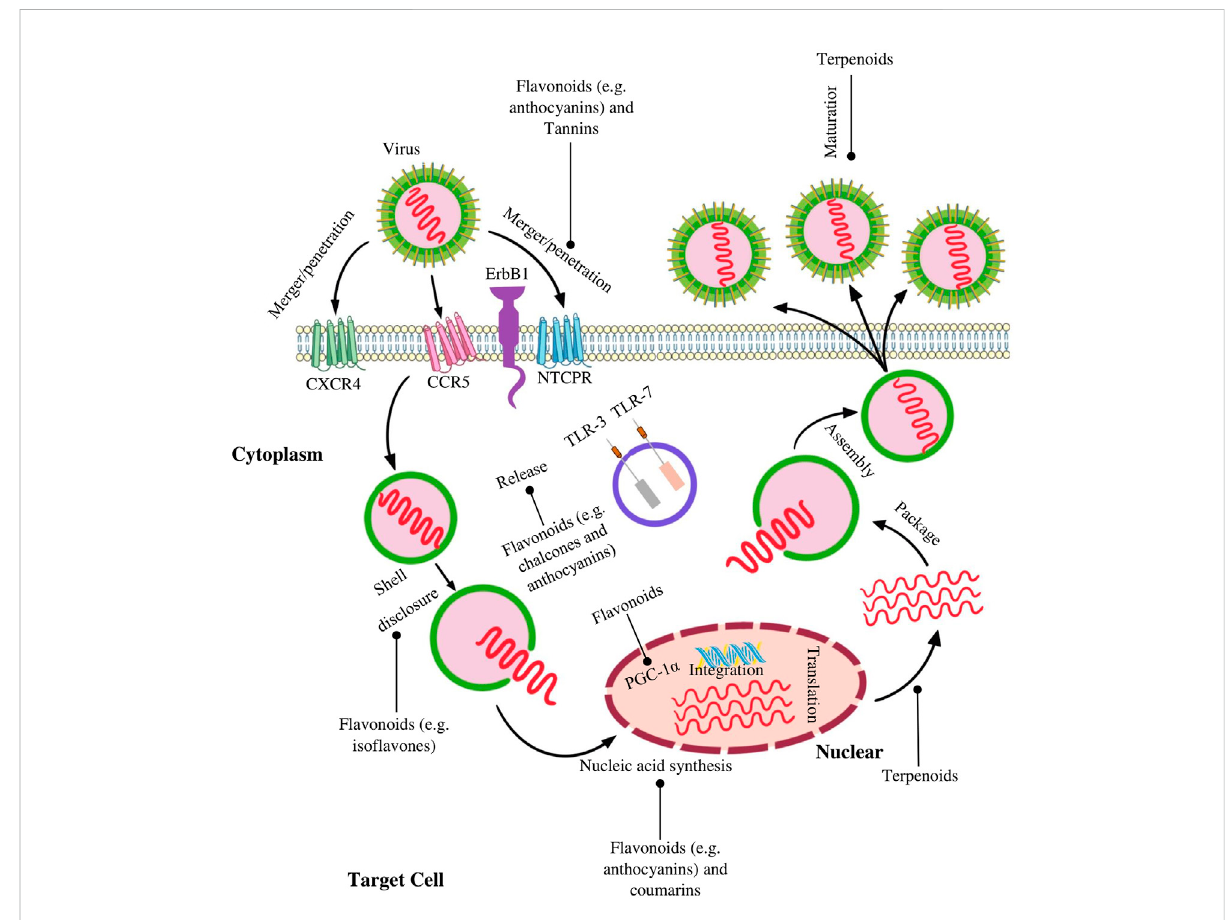
FIGURE 5 Targets and processes affected by some natural polyphenolic compounds in viral infections. This scheme shows the possible mechanisms of the antiviral action of the main classes of natural polyphenolic compounds. Flavonoids have been found to inhibit merger, integration, and reverse transcription. Inhibition of protease, reverse transcriptase, replication and maturation are among the anti-HIV mechanisms of some terpenoids. Coumarins inhibit transcriptase and activation of nuclear factor-kappa B (NF-kB). Note: PGC-1 α , Peroxisome proliferator-activated